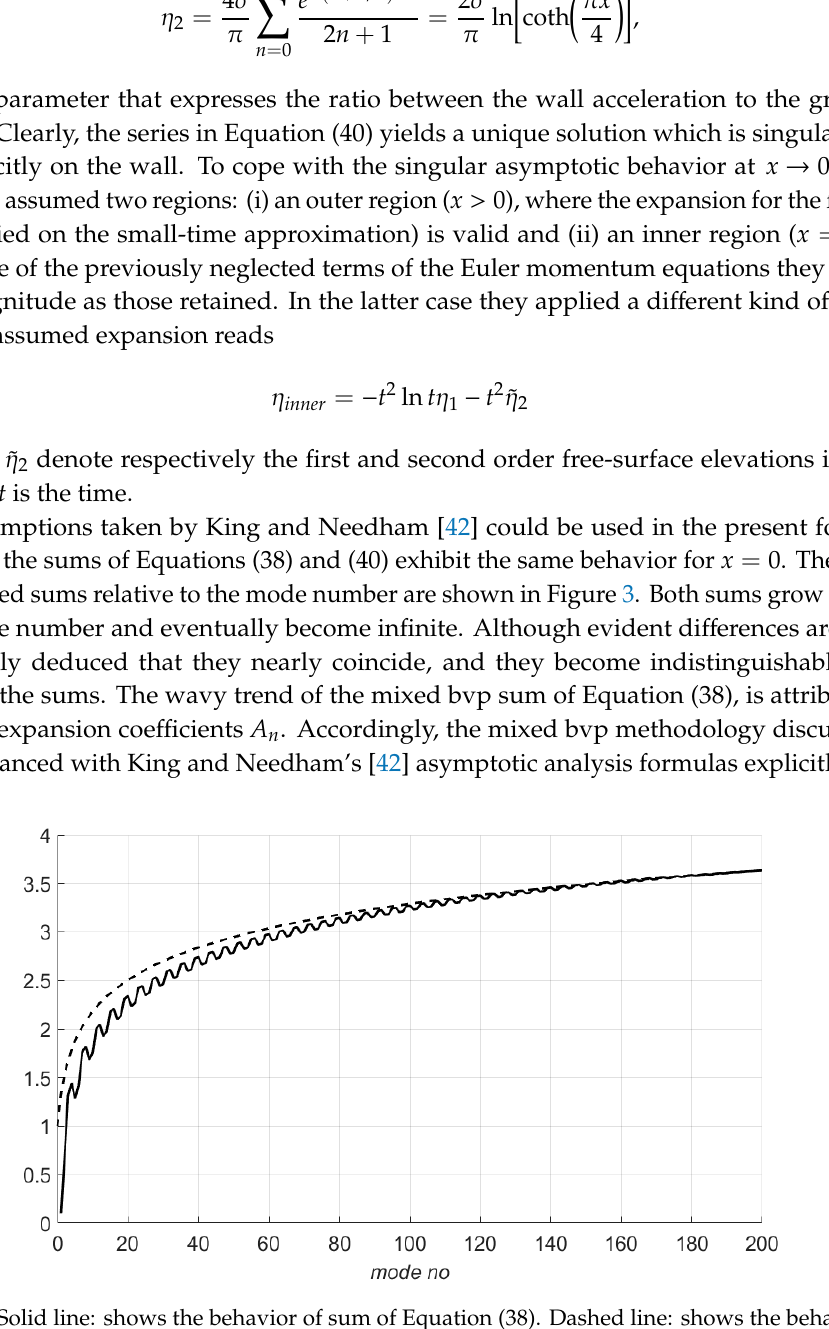
Figure 3. Solid line: shows the behavior of sum of Equation (38). Dashed line: shows the behavior of sum of Equation (40), both for x = 0; a = 0.5, v = 300, t = 0.01